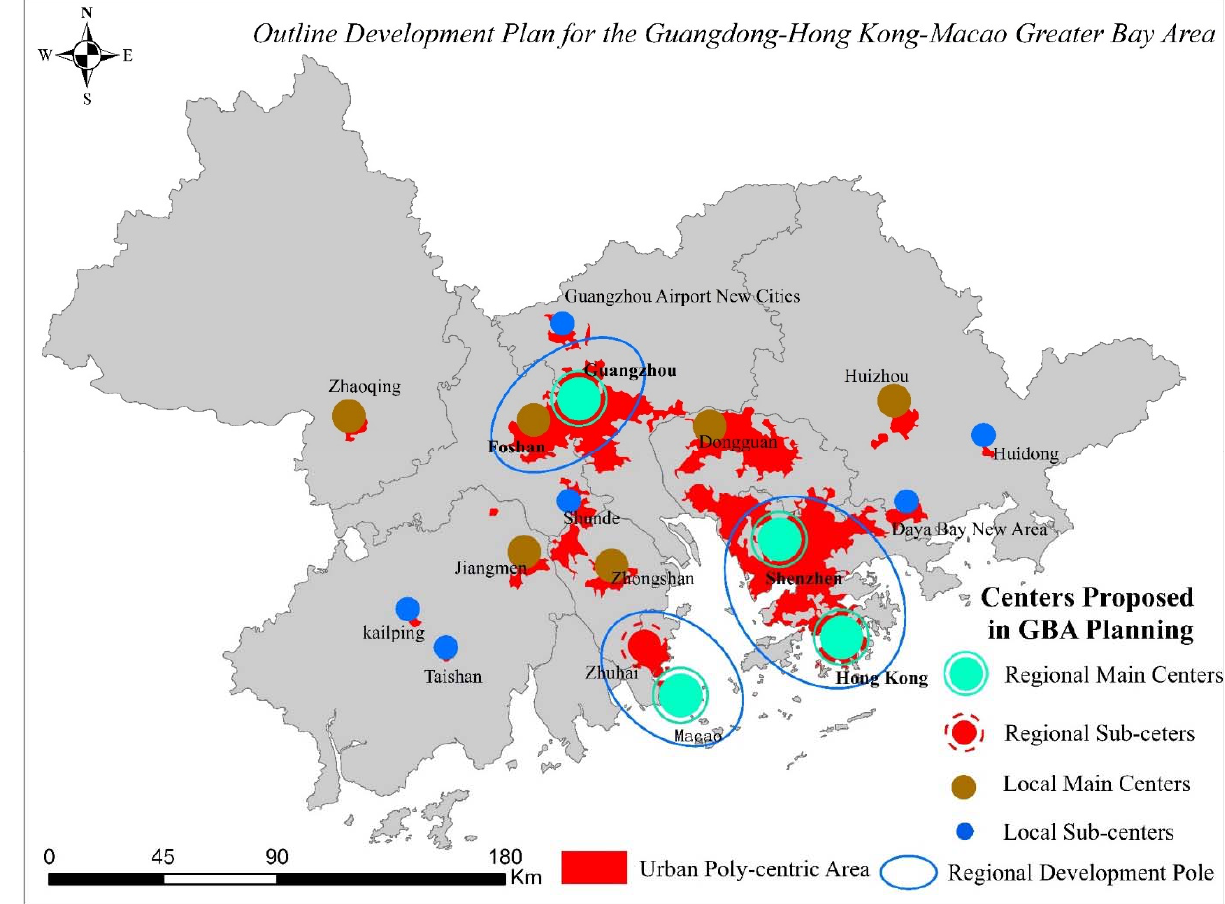
Figure 8. Comparison between identified urban poly-center and that proposed in the GBA development planning.